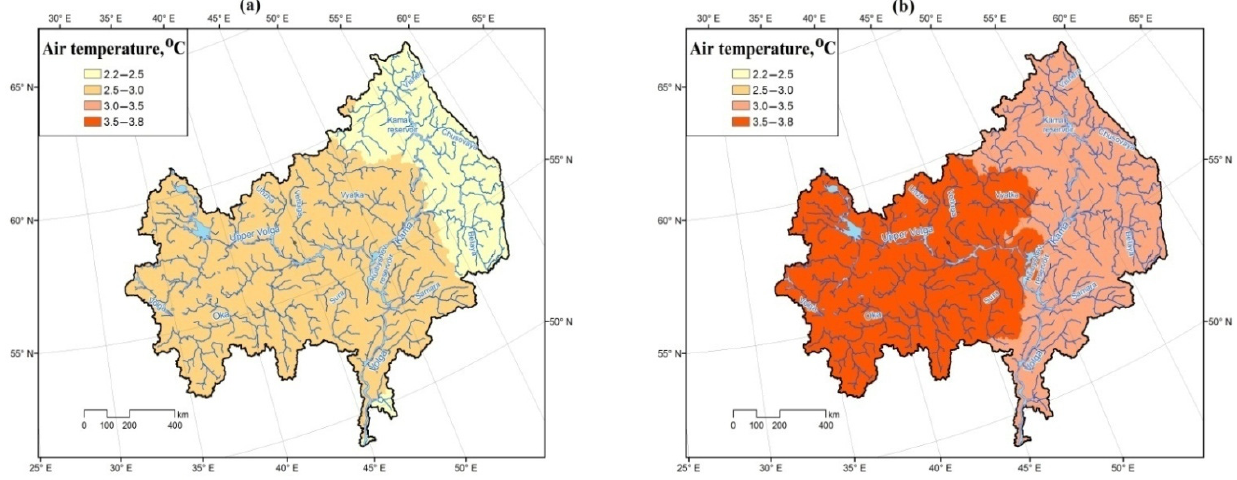
Figure 8. Anomalies of mean annual air temperature in the Volga basin under global warming of 1.5 °C ( a ) and 2 °C ( b ) in the 21st century relative to the average values of the baseline period 1970– 1999.